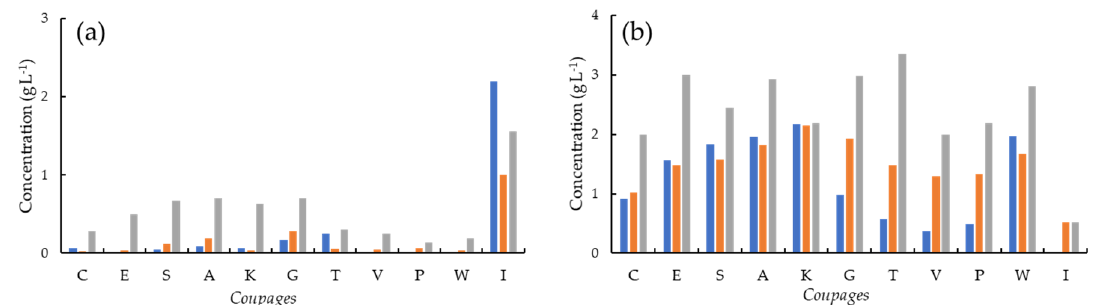
Figure 7. Chart bars of concentrations of representative organic acids. ( a ) Malic acid; ( b ) lactic acid. Bar assignation: blue = enzymatic; orange = FTIR; grey = HPLC. Cava class assignation: see Table 2.